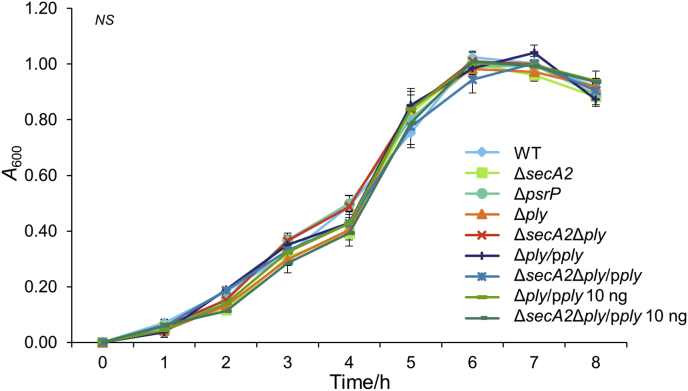
Growth curves for S. pneumoniae WT, mutants and complemented strains. Growth rate analyses of S. pneumoniae wild type, ΔsecA2, ΔpsrP and Δply mutant strains were carried out to assess if inactivation of these genes affected bacterial growth that might influence subsequent assays. Complemented ply strains were induced with 0 and 10 ng ml−1 of nisin as mentioned in graph legend to show that addition of nisin had no effect on bacterial growth. Strains were grown in THY medium until cultures reached stationary phase. There are no significant differences (NS) between the WT, mutants, and nisin induced complemented strains in growth rates or growth yield. (n = 2).